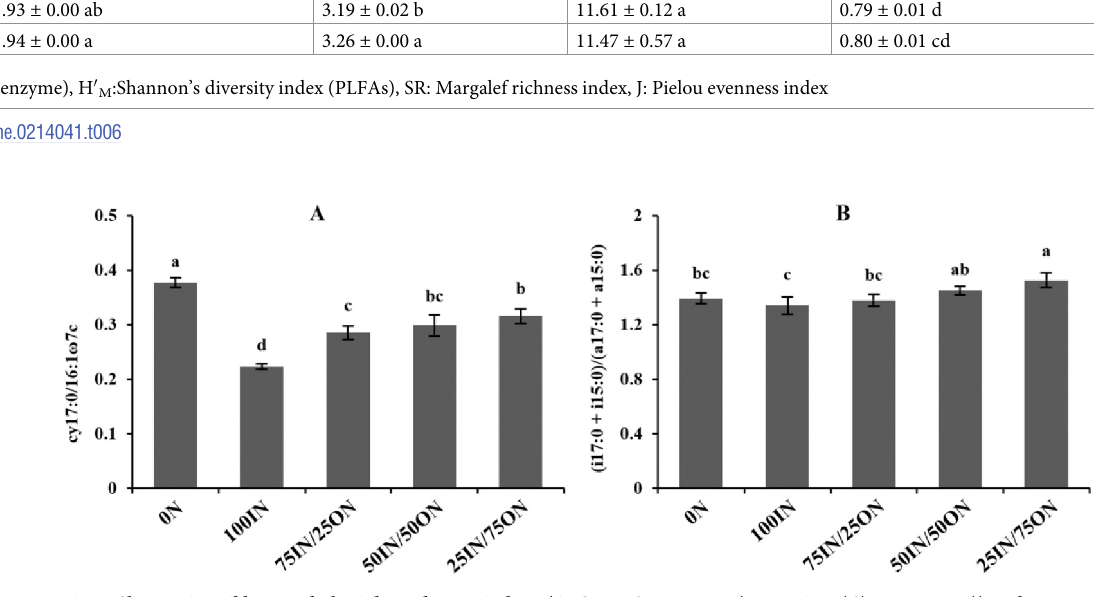
Fig 6. Changes in soil bacterial physiological stress indices (A: Cy17:0/16:1 ω 7c; B: (i17:0 + i15:0)/(a17:0 + a15:0)) under different fertilization